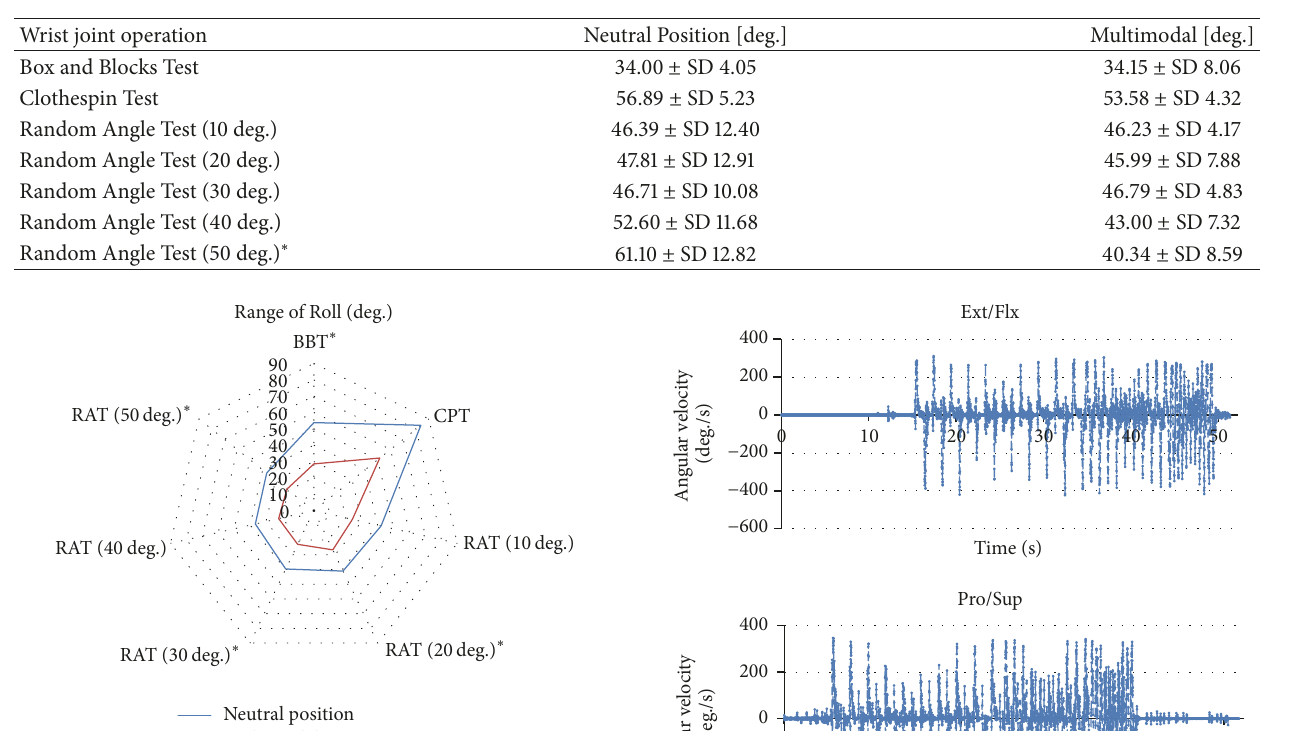
Table 3: Mean of Range of Pitch ( ∗ 𝑝 < 0.05 , 𝑁 = 4 ).